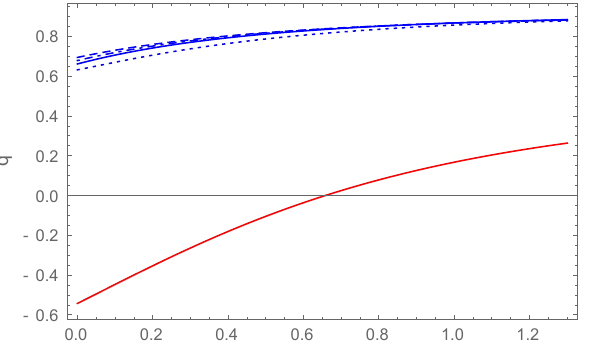
(cid:0) (cid:1) Tg µν − T µν